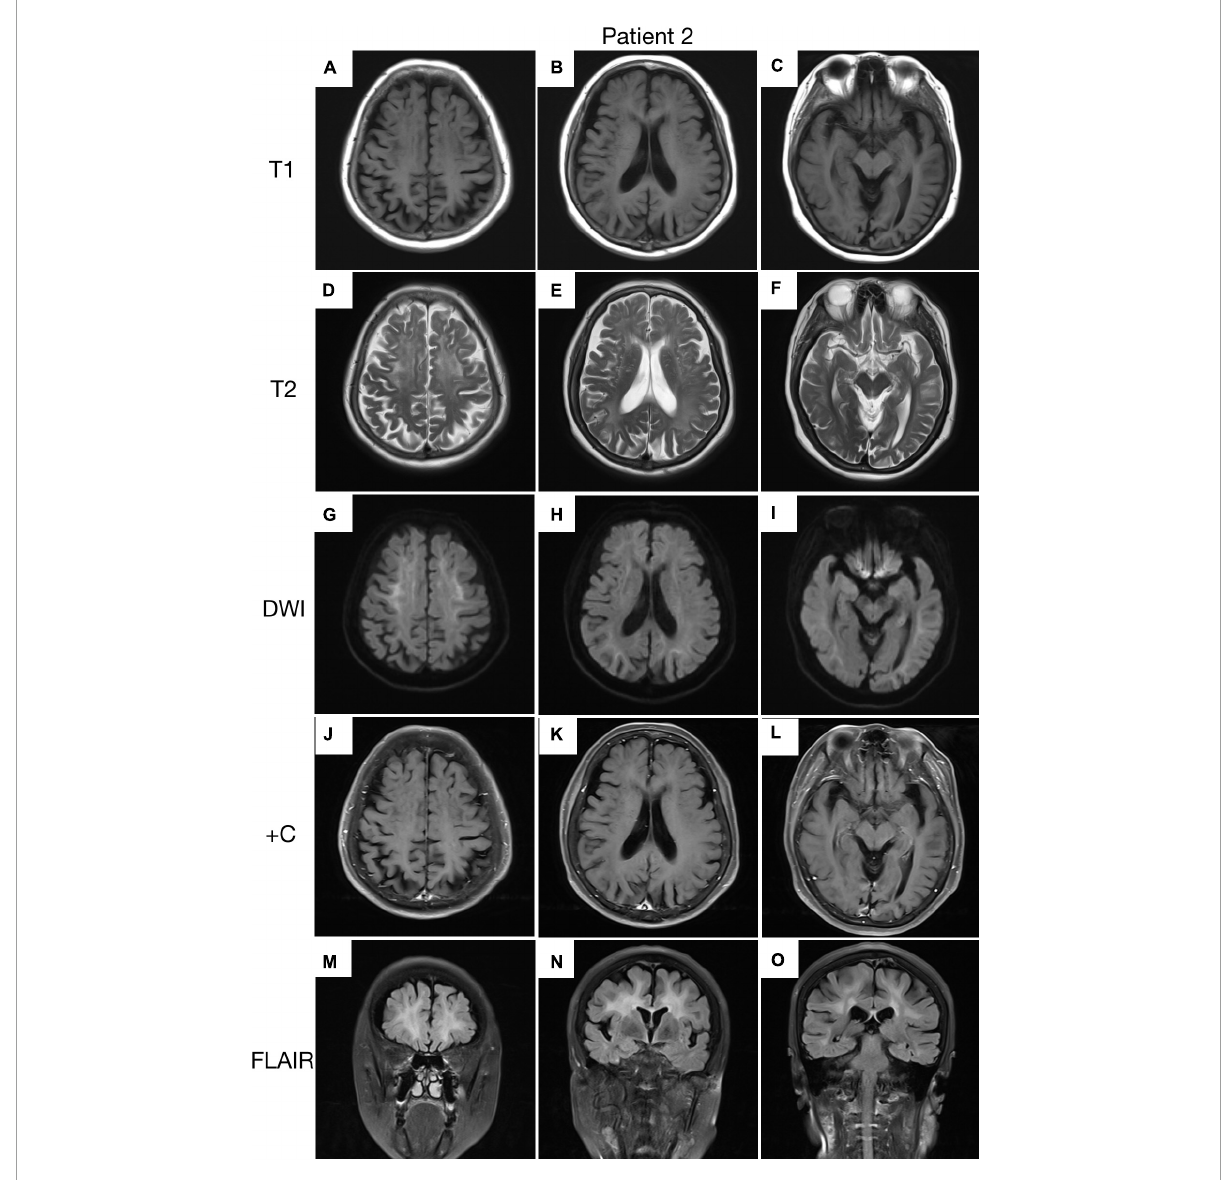
FIGURE4 Brain MRI scan of patient 2. Cerebral atrophy was observed on T1 images (A–C) . T2 (D–F) and FLAIR (M–O) images revealed severe leukoencephalopathy. Diffusion-weighted imaging (DWI) images revealed high linear signal in the corticomedullary junction (G–I) . No significant enhancing lesions were observed (J–L)